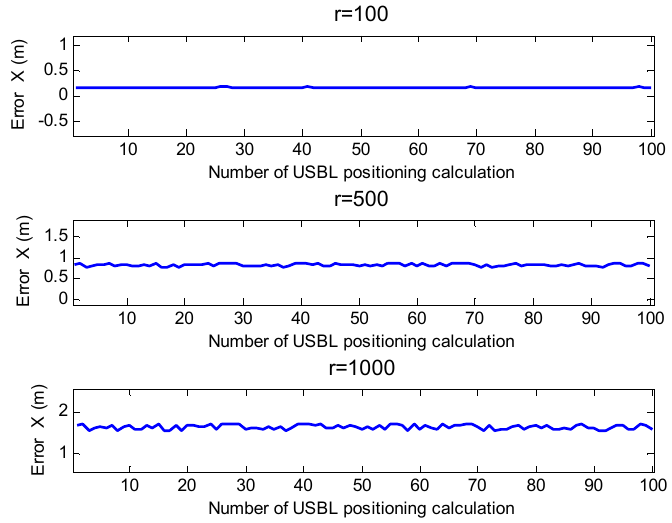
Figure 15. Horizontal positioning error at different positioning distances (by Sun’s method). Figure 16 is the horizontal positioning error diagram of the USBL positioning model based on the rotating array and reusing elements method proposed in this paper. It can be seen from Figure 16 that the positioning error was 0.12 m when the horizontal bypass distance was 100 m. When the horizontal bypass distance was 500 m, the positioning error was 0.57 m, and when the horizontal bypass distance was 1000 m, the positioning error was 1.14 m.